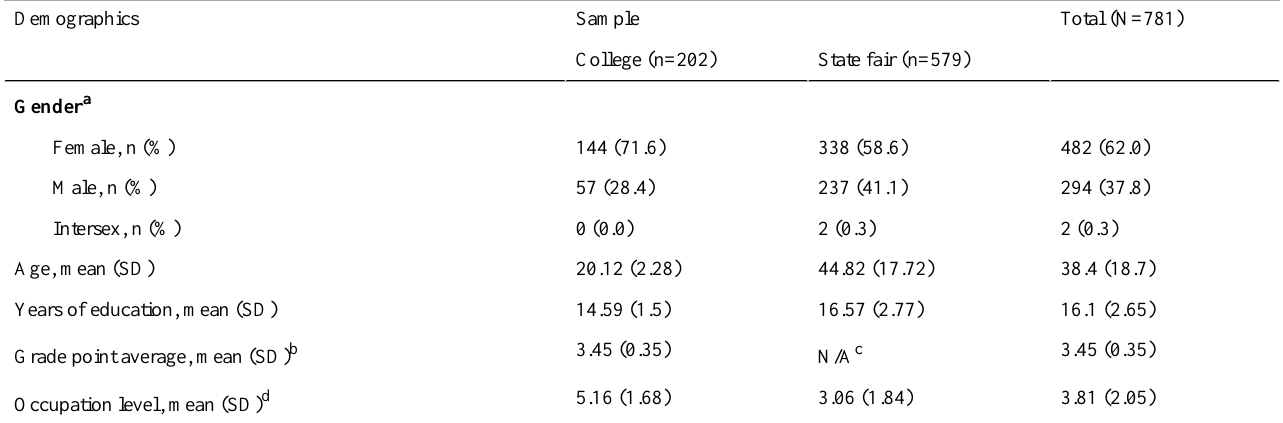
Table 1. Participant demographics by